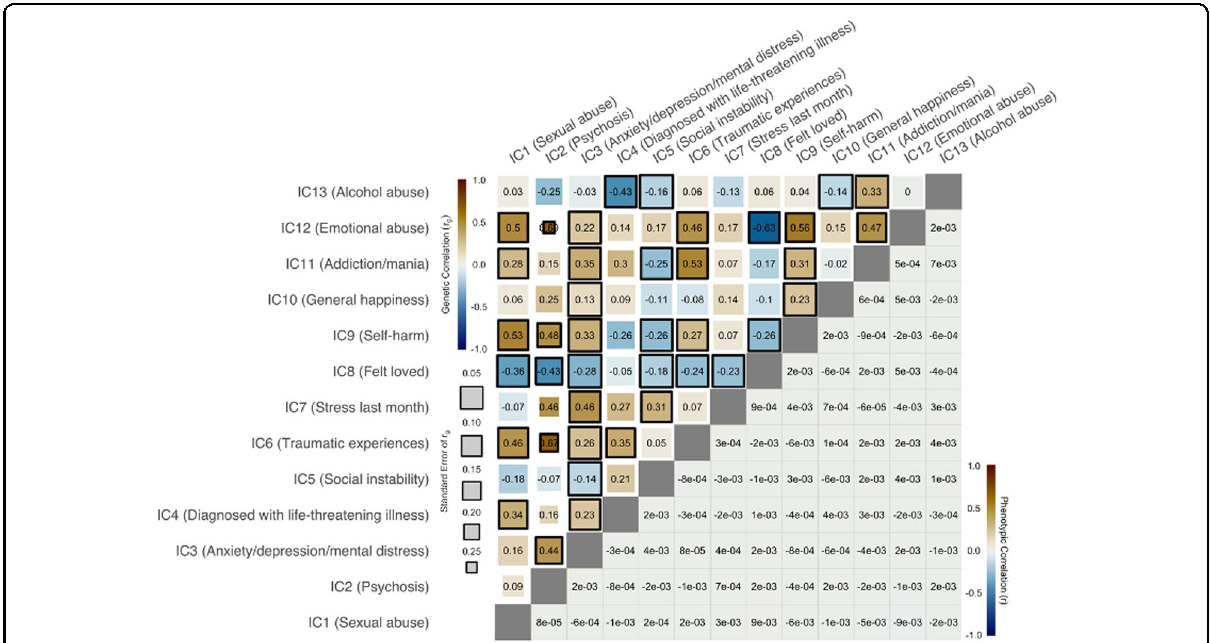
Fig. 4 Phenotypic and genetic correlation between the ICs. The lower half of the IC by IC matrix depicts phenotypic correlations, re fl ecting the Pearson correlation of subject level component scores between independent components. As expected by ICA design, correlations were close to zero. The upper half of the matrix depicts the genetic correlations ( r g ), indicating signi fi cant genetic correlations in 40 of 78 tests. Size of the boxes indicate standard error and signi fi cant correlations ( p < FDR) are indicated with a black